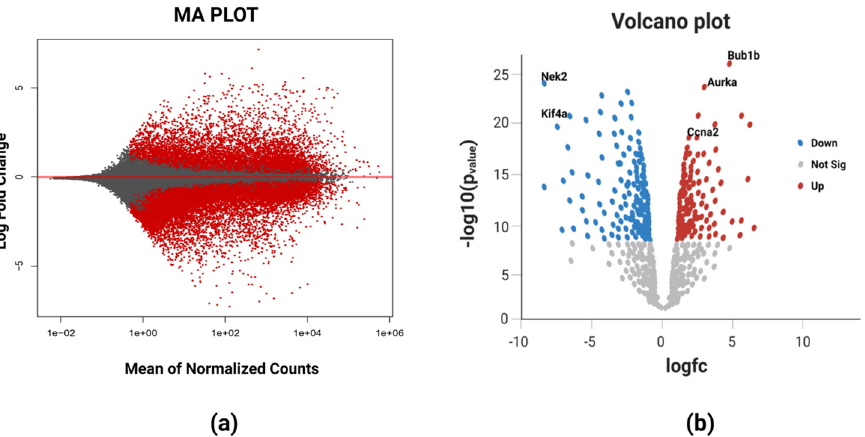
Figure 2. ( a ) MA plot of breast cancer representing the log fold change against mean expression using the DESeq2 dataset. The red dots corresponding to the positive x -axis represent upregulated differentially expressed genes, while those corresponding to the negative x -axis represent downregulated differentially expressed genes. ( b ) Volcano plot showing the most significant differentially expressed genes. The blue color dots on the left portion of the plot represent the downregulated DEGs, red color dots on the right portion of the plot represent upregulated DEGs, and white color dots at the bottom portion depict the non-significant DEGs. BUB1B is the most significant DEG based on its highest value of log fold change.